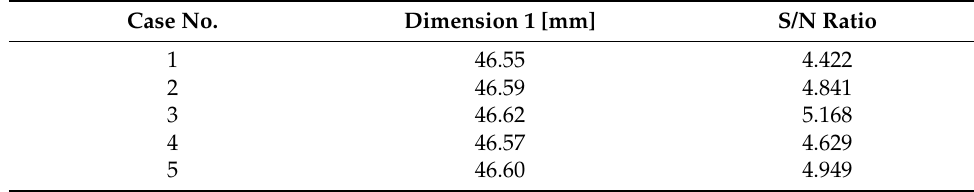
Table 17. S/N ratio of measurement 1 for open